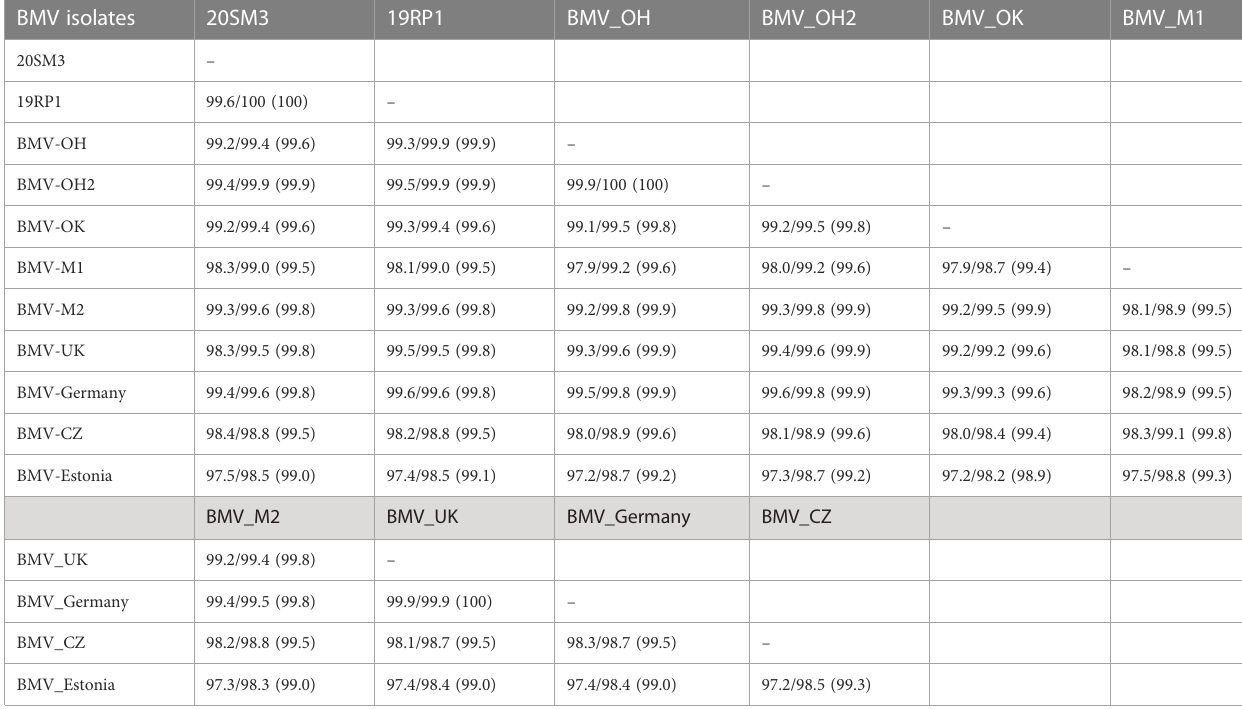
TABLE 2 Nucleotides/amino acid sequence identity (similarity) of RNA2/RNA2a genome of brome mosaic virus (BMV) isolates from Kansas and other known BMV isolates retrieved from GeneBank. BMV